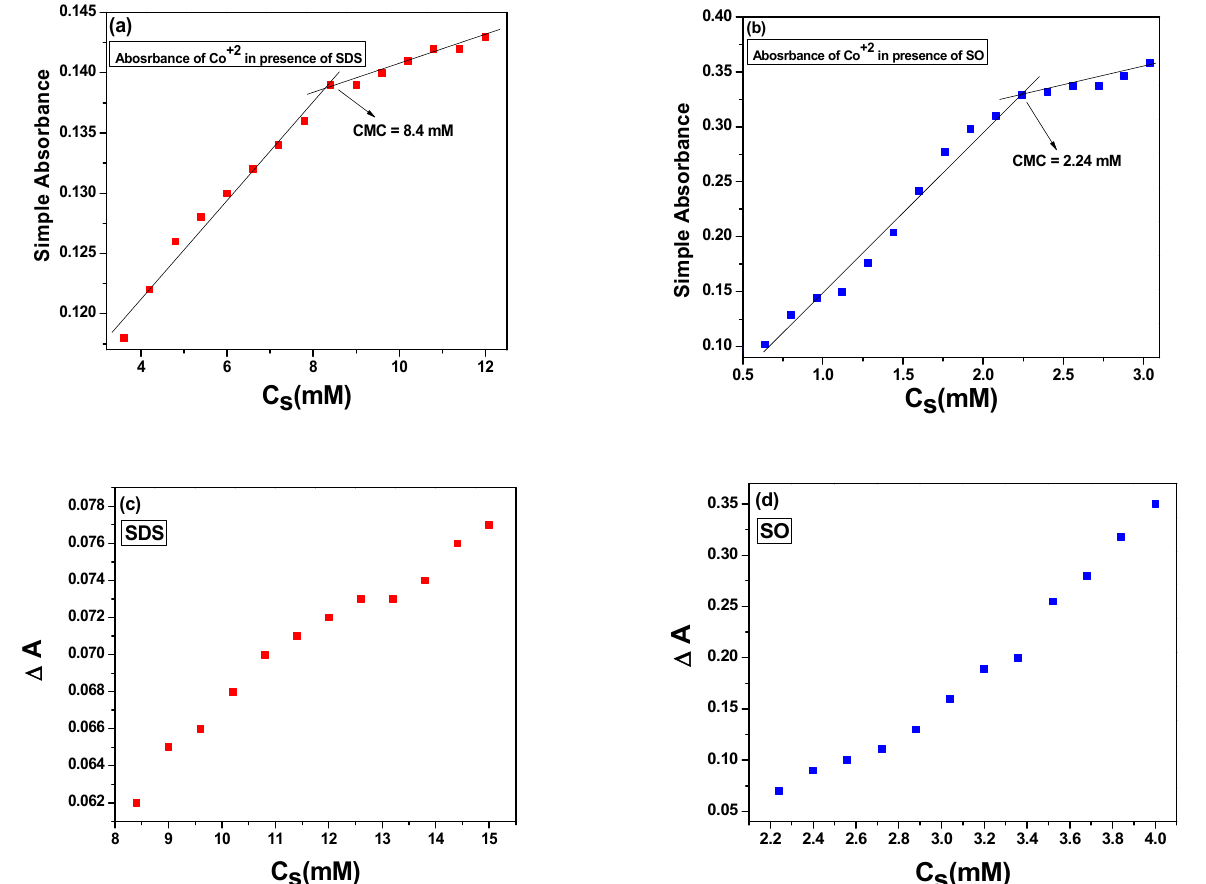
Figure 2. ( a ) Plot for simple absorbance of CoCl 2 as function of SDS concentration. ( b ) Plot for simple absorbance of CoCl 2 as function of SO concentration. ( c ) Plot for differential absorbance of CoCl 2 as function of SDS concentration. ( d ) Plot for differential absorbance of CoCl 2 as function of SO concentration.